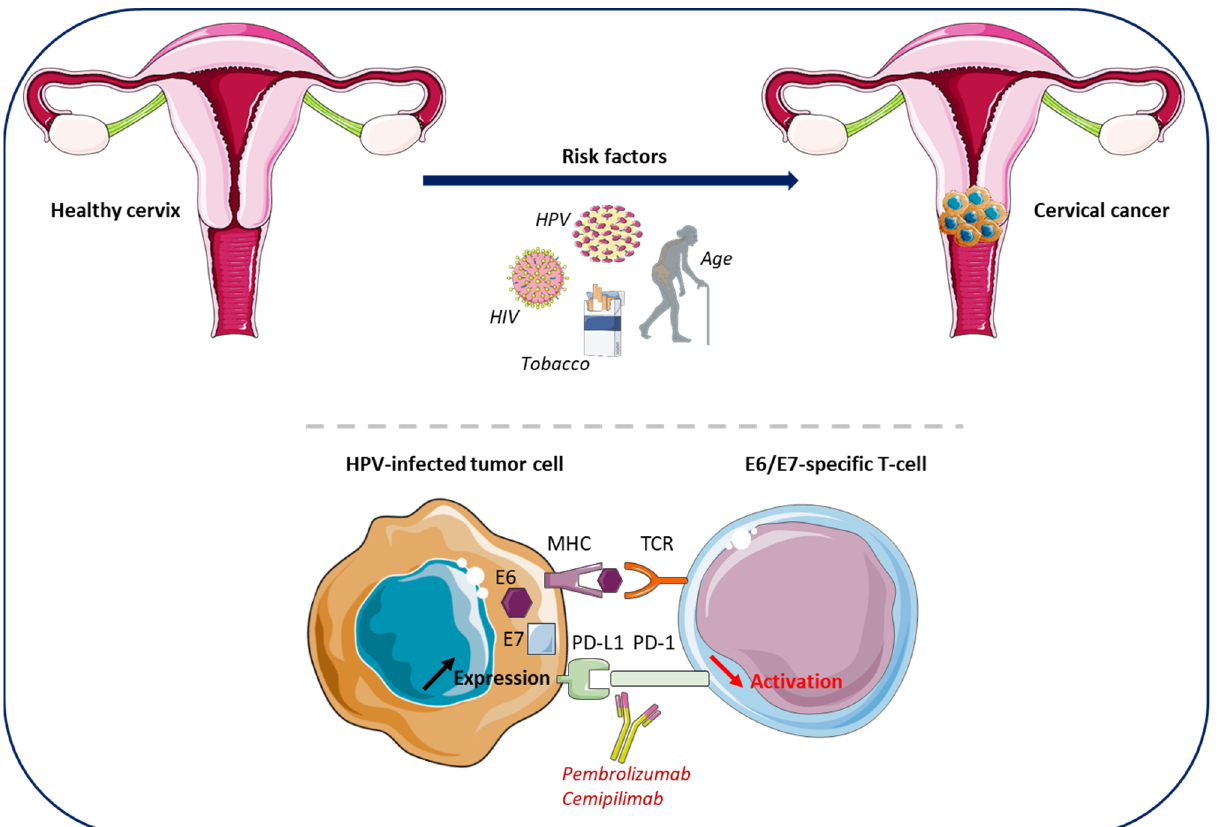
Figure 2. Cervical cancer (CC) — development, immune environment and approved treatments. HPV represents the major risk factor for CC development. Other risk factors include sexually transmittable co ‐ infections such as HIV, Chlamydia trachomatis or genital HSV, tobacco, early age of sexual debut, multiple sexual partners, a high number of childbirths, long ‐ term use of oral contraceptives, and age. HPV infection is highly prevalent but is eradicated in most cases by the immune system. However, a small percentage of women will develop chronic infections, resulting in the development of cancer cells that evade the immune system and, thus, leading to tumor development. One mechanism of HPV ‐ infected cells to overcome the immune response is an increase of the PD ‐ L1 expression at their cell surface, resulting in the inhibition of the T ‐ lymphocyte activation through the interaction with PD ‐ 1. This inhibition can be reversed using anti ‐ PD ‐ 1 antibodies (Pembrolizumab, Cemipilimab). CC, cervical cancer; HIV, Human Immunodeficiency Virus; HPV, Human Papilloma Virus; HSV, Herpes Simplex Virus; PD ‐ 1, programmed cell death protein 1. The figure was drawn by using pictures from Servier Medical Art. Servier Medical Art by Servier is licensed under a Creative Commons Attribution 3.0 Unported License (https://creativecommons.org/licenses/by/3.0/ (accessed on 2 September 2022)).